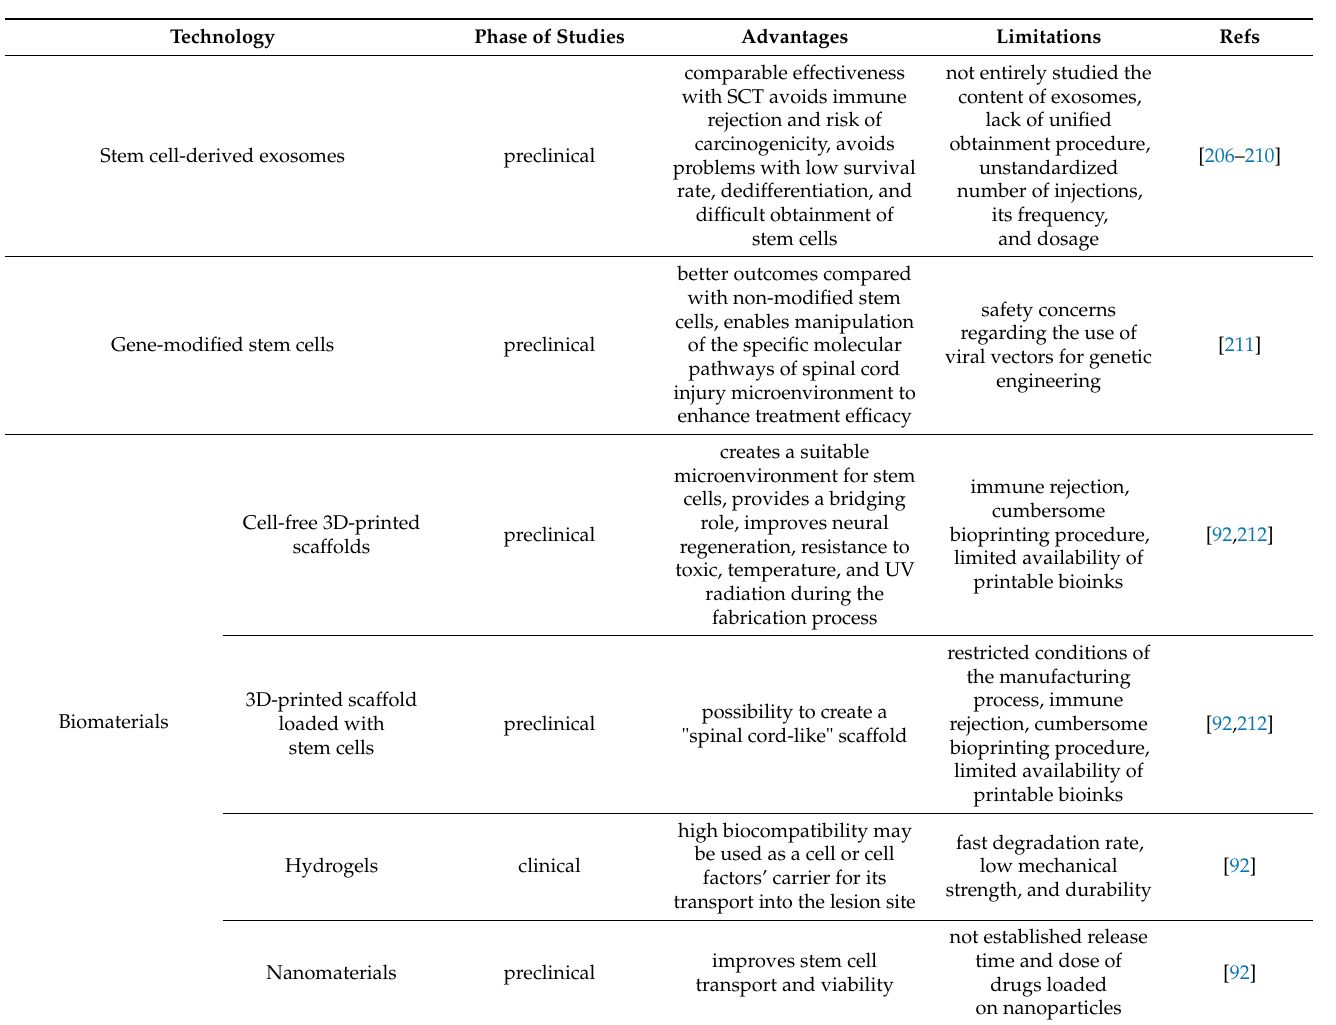
Table 3. Emerging therapies based on Stem Cell